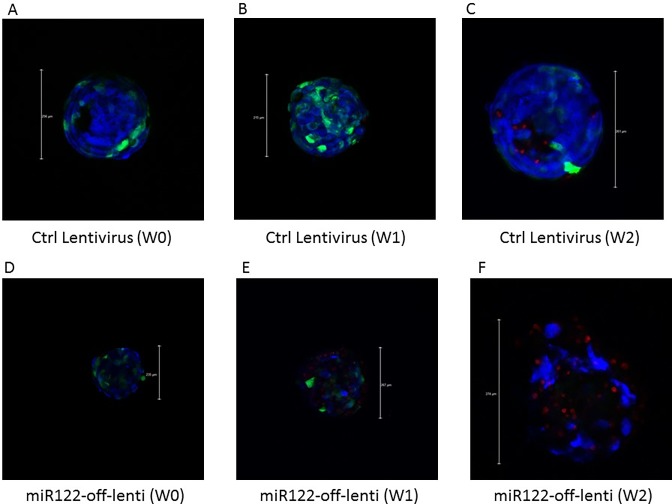
Liver organoid live/dead cell assay.Liver organoids infected with either control lentivirus with MOI = 5 (A-C) or with lentivirus expressing miR-122 inhibitor at different weeks following infection. Organoids were fixed, with calcein Blue and Ethidium homodimer and images were taken using a Leica confocal microscope. Blue = cell nuclei, Red = dead cells, Green = lentivirus GFP expression. W denotes week.